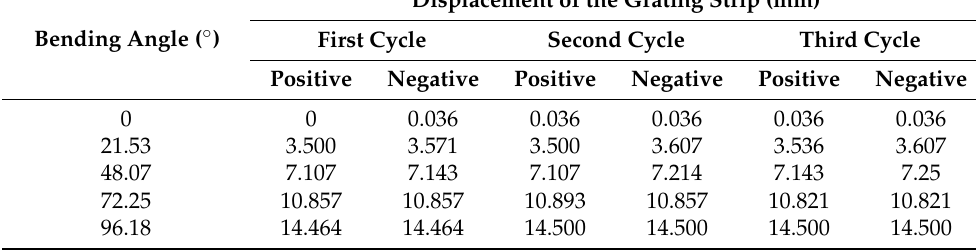
Figure 16. Five calibration points set by five wooden blocks with different heights. ( a ) Wooden blocks used to set bending angles; ( b ) Bending angle is 0 ° ; ( c ) Bending angle is 21.53 ° ; ( d ) Bending angle is 48.07 ° ; ( e ) Bending angle is 72.25 ° ; ( f ) Bending angle is 96.18 ° . Table 2. Calibration experimental data.